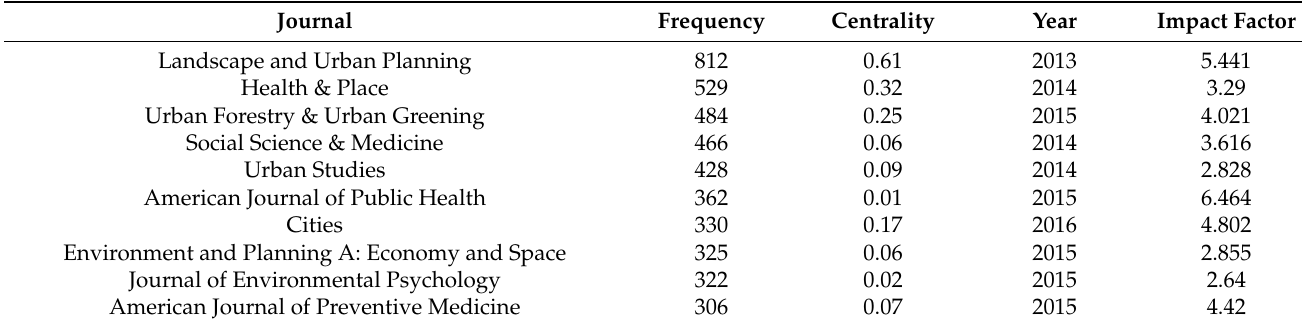
Table 7. Top 10 productive journals in healthy urban planning research: 1981–2020.